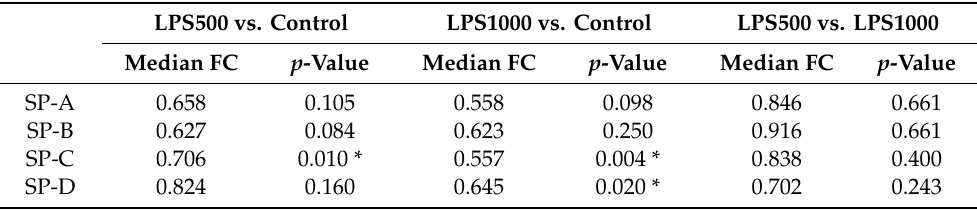
Figure 4. Total leukocyte count in arterial blood before instillation (BI) of saline (Control) or different doses of lipopolysaccharide (LPS100, 500, and 1000 μ g/kg), 1 h after instillation (Model) and therapy (Th) administration during 4 h of experiment, expressed as a percentage (%). Control vs. LPS-treated groups * p < 0.05, ** p < 0.01. Table 1. Median fold change (FC) and p -values for SPs gene expression after treatment with 500 and 1000 µ g / kg LPS. Significant values are marked with an asterisk